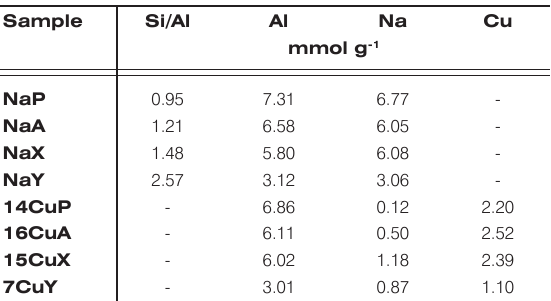
Table 1. Composition of the